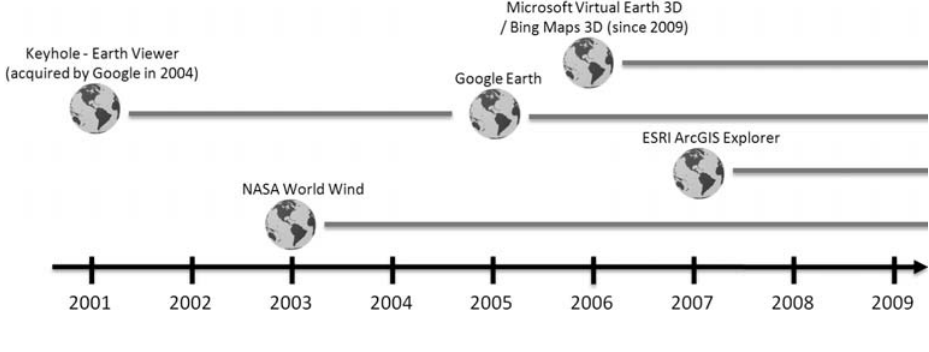
Figure 1. Selection of major, freely accessible Virtual Globe software and their first